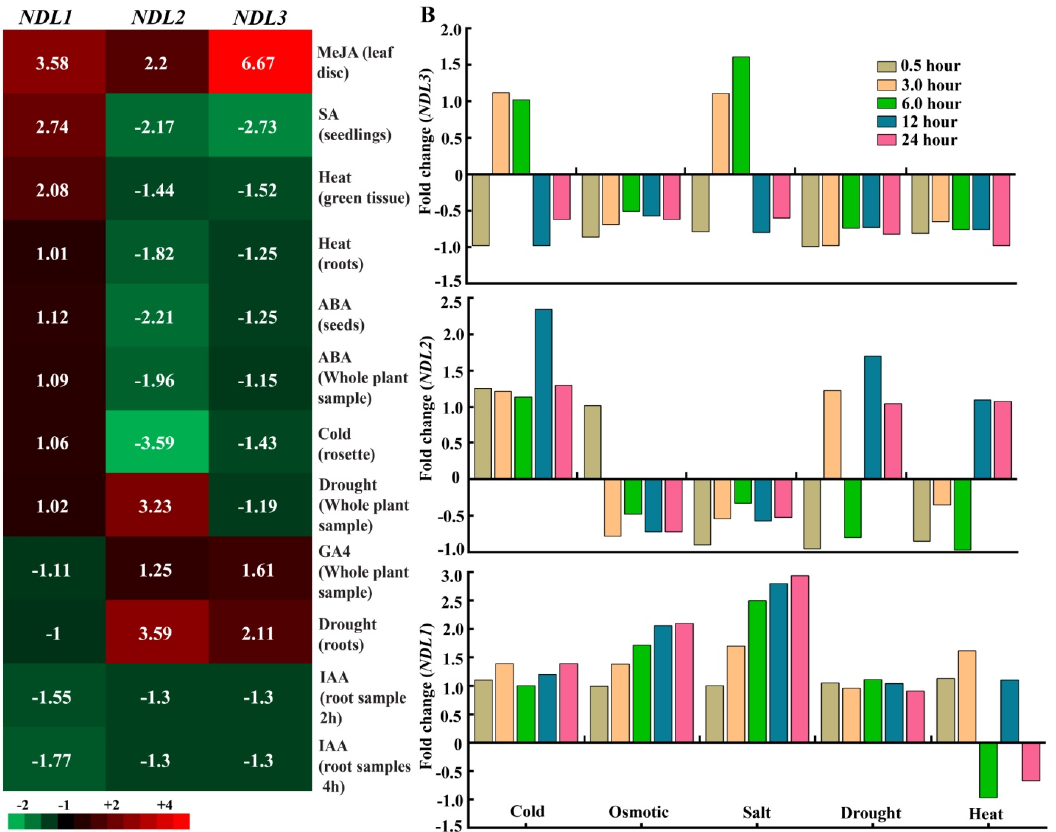
Figure 4. In silico expression analysis of NDL gene family during abiotic stress and hormonal treatment using genevestigator and eFP browser: ( A ). Comparative in-silico expression analysis of NDL1, NDL2, and NDL3 using GENEVESTIGATOR microarray data, under different abiotic stress and hormonal treatments. ( B ). In silico analysis of NDL1, NDL2, and NDL3 during abiotic stress treatments at different time points (0.5, 3, 6, 12, and 24 h) comparative expression is shown as fold change compared to no stress control.